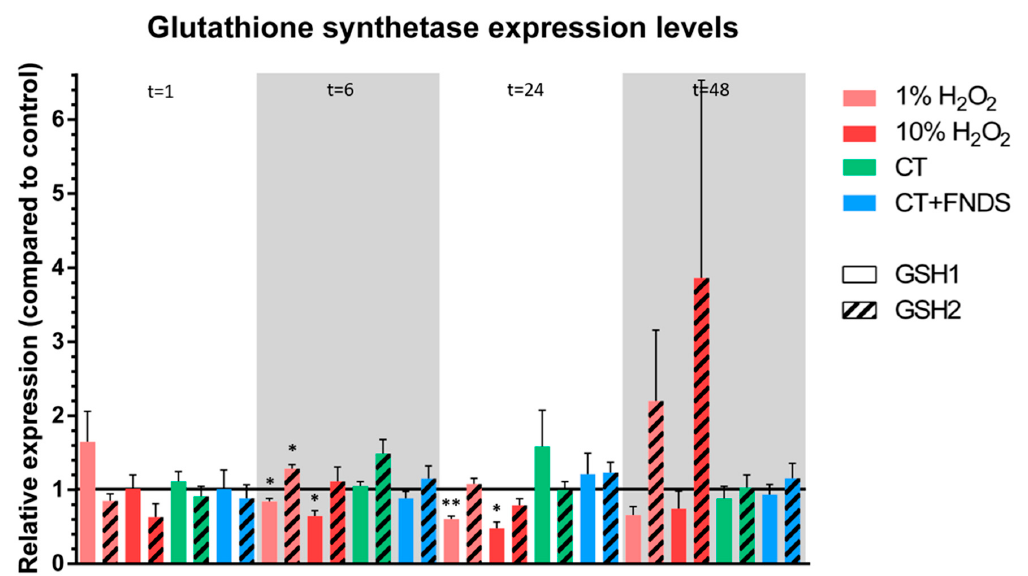
Figure 4. Relative expression of glutathione synthetases, both the enzyme that is involved in the first step of glutathione synthesis (GSH1, filled bars) and the enzyme that is involved in the ATP-dependent step of glutathione synthesis (GSH2, striped bars). The colors represent di ff erent conditions, measured at 1 / 6 / 24 / 48 h, respectively. Values are averages out of 3–4 independent qPCR runs that were performed in duplicates. Error bars show the standard error of the mean. Significance was tested against the control (* p ≤ 0.05, ** p ≤ 0.01).